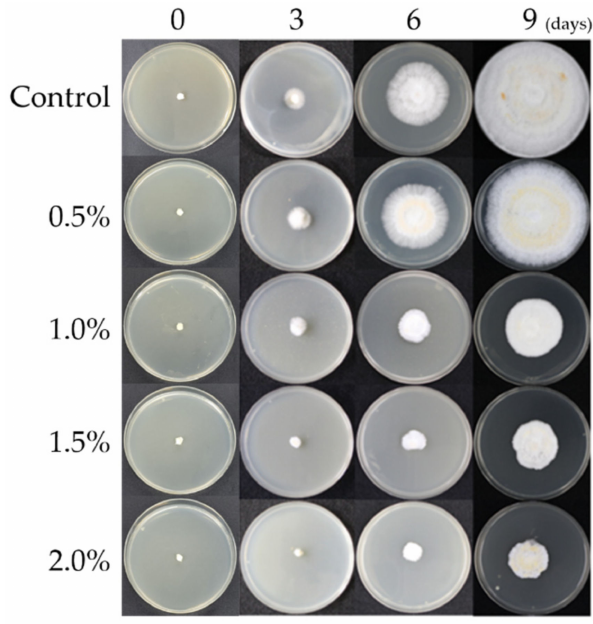
Figure 1. Comparison of growth of control and NaCl-treated group (0.5%, 1%, 1.5%, 2%) medium (culture). Table 3. Mycelium growth in PDA medium (culture) (unit: mm).